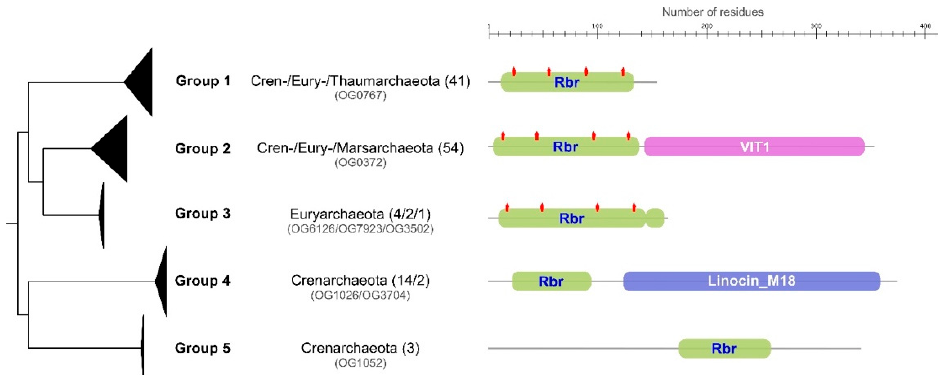
Figure 4. Rubrerythrin domain architecture in acidophilic archaea. The phylogenetic tree is collapsed by clades representing specific protein domain architectures (groups 1–5). Specific orthogroups with phylum association are indicated by each clade with the number of sequences in parentheses. Rbr domains are represented in green, VIT1 domain in purple and Linocin M18 in blue. Diiron metal motifs identified are represented as red markings on Rbr domains. Scale bar represents protein length in residues.